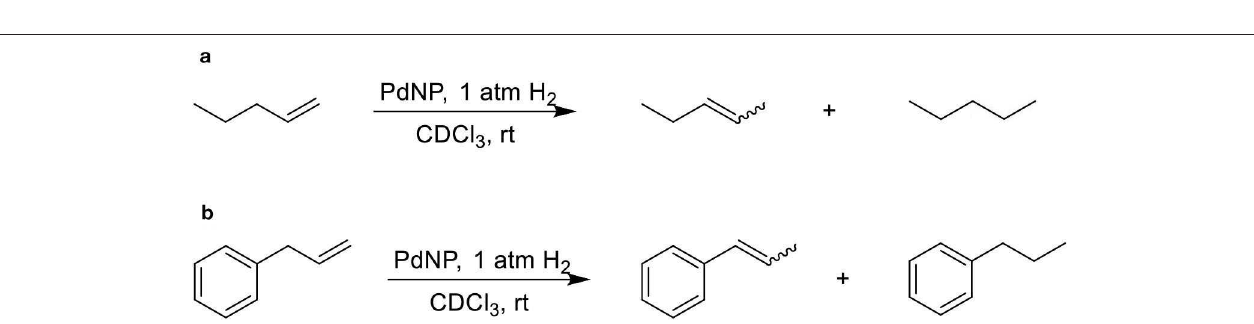
SCHEME 1 | The model catalytic reactions used to compare the activity and selectivity of colloidal Pd nanoparticle catalysts: (a) pen-1-ene and (b) allylbenzene.